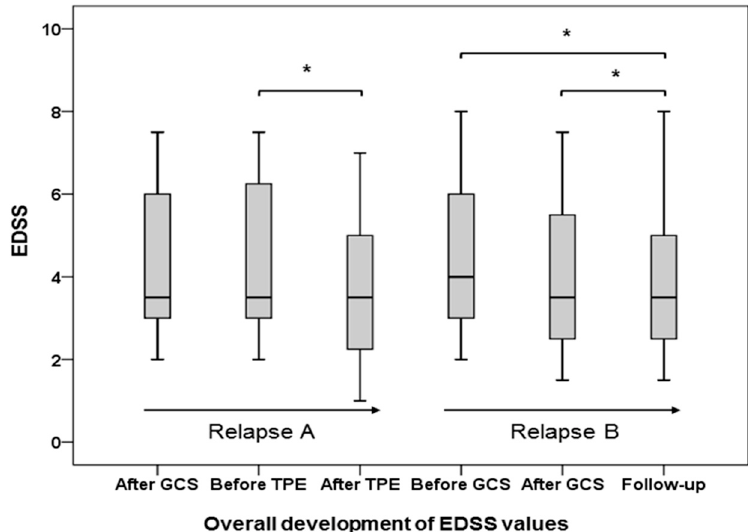
Figure 3. Boxplot graphs displaying the median (bold line), minimum (lower T-line), maximum (upper T-line), first quartile (lower part of box), and third quartile (upper part of box) of expanded disability status scale (EDSS) values during treatment of relapses A and B until follow-up examination. Relapse A: initial GCS-unresponsive relapse treated with GCS and TPE; Relapse B: first new relapse after TPE treated with GCS; * EDSS changes were significantly different ( p < 0.001) in a non-parametric Wilcoxon test.